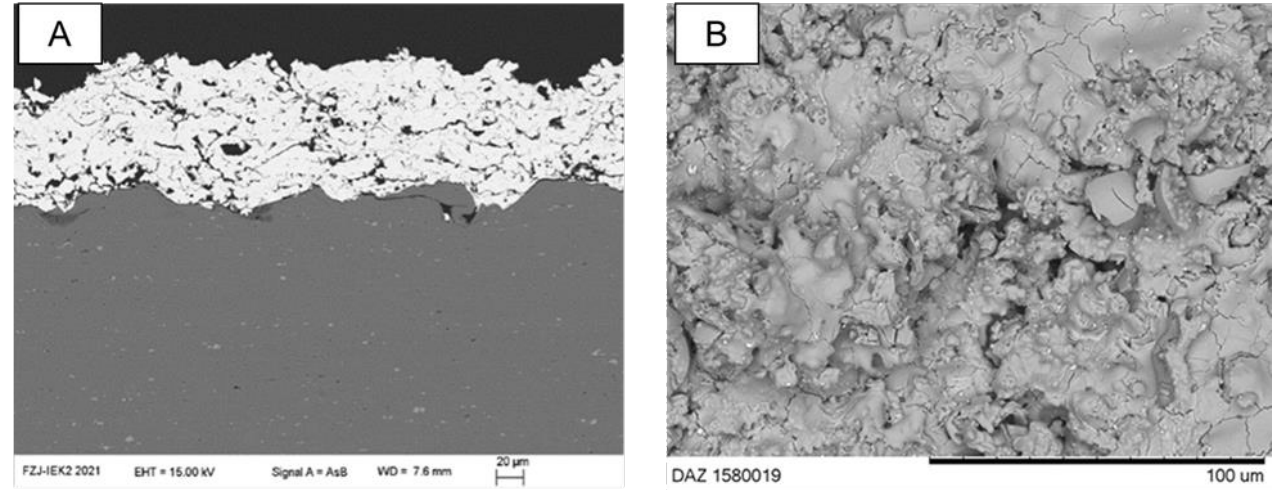
Figure 2. Cross-sectional microstructure ( A ) and surface morphology ( B ) of the as-sprayed YSZ coating.